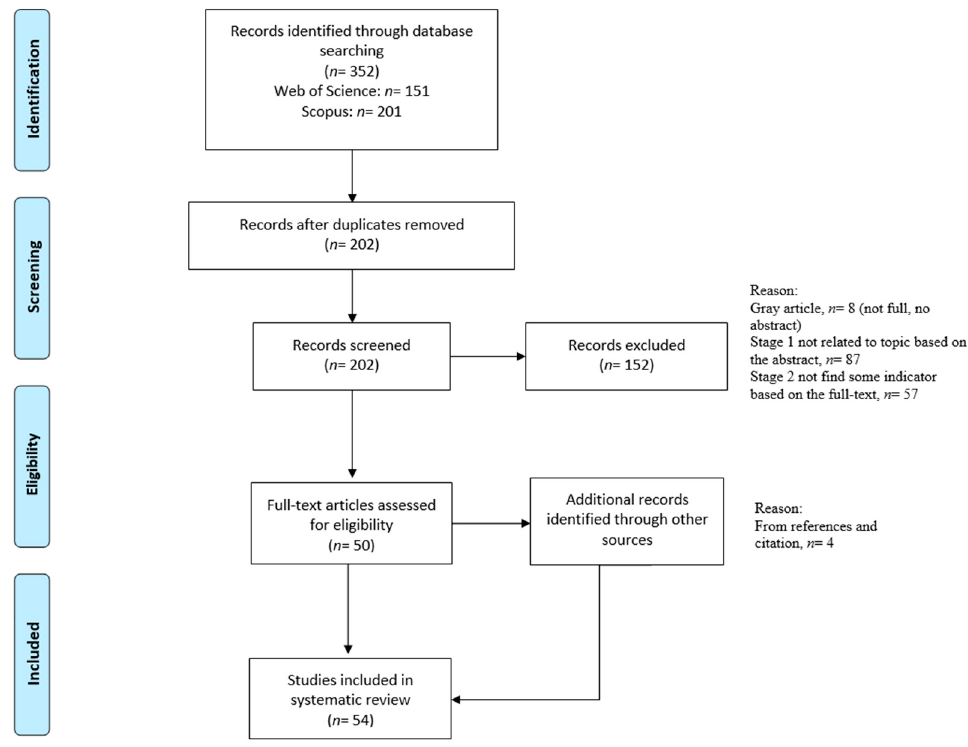
Figure 1. The flowchart of the PRISMA approach used in the systematic literature review study.